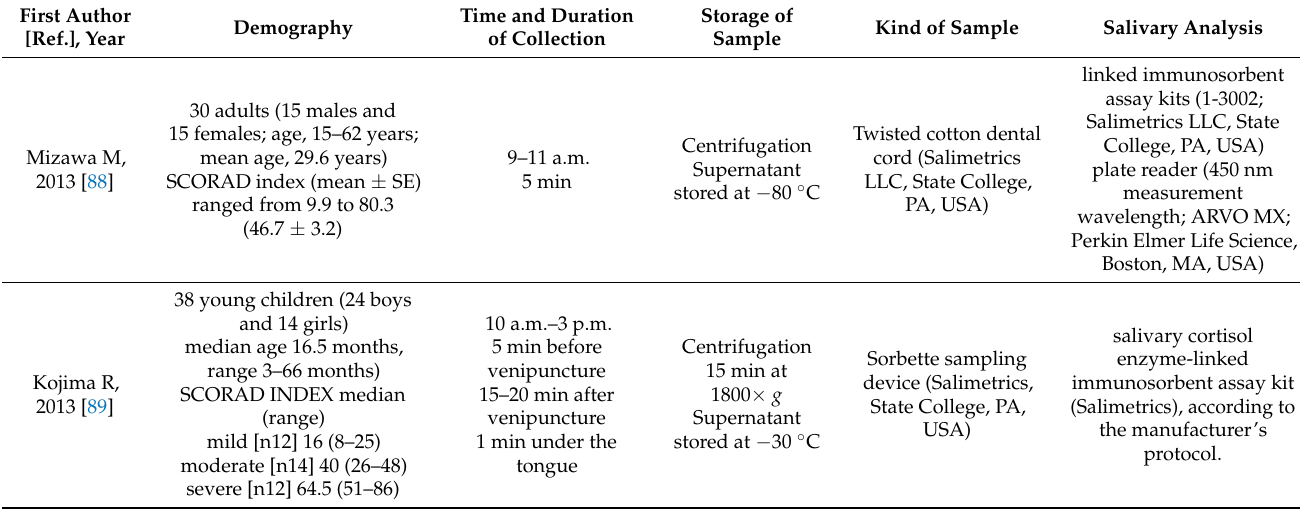
Table 4. Summary of the studies performed on the saliva of patients with atopic